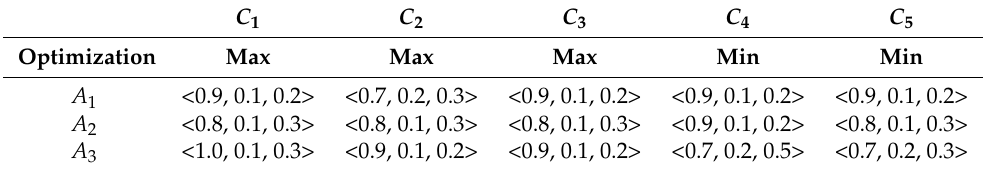
Table 8. Group decision-making matrix.